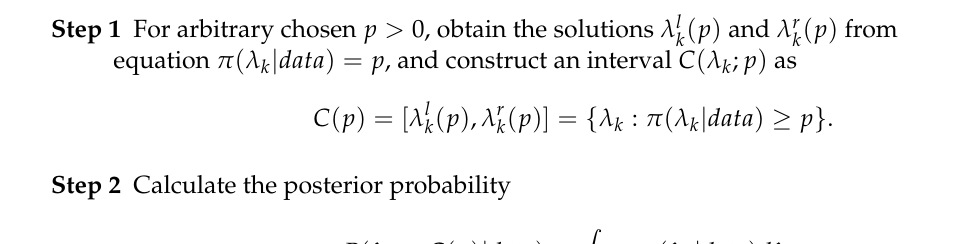
Algorithm 1: Bayesian HPD credible interval